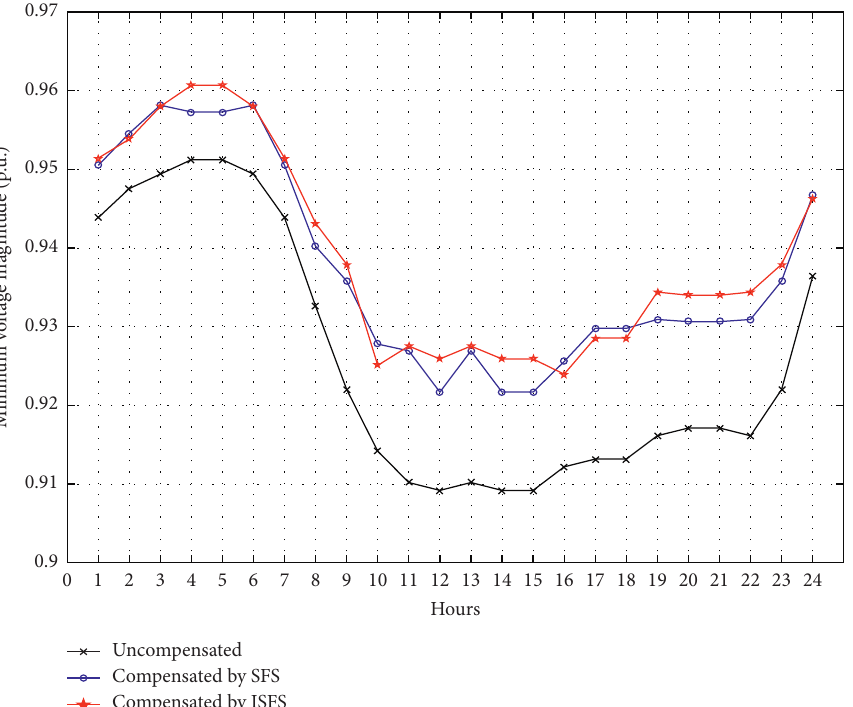
Figure 15: Minimum bus voltages of 69-bus network within 24-hour interval before and after compensation in scenario 2.